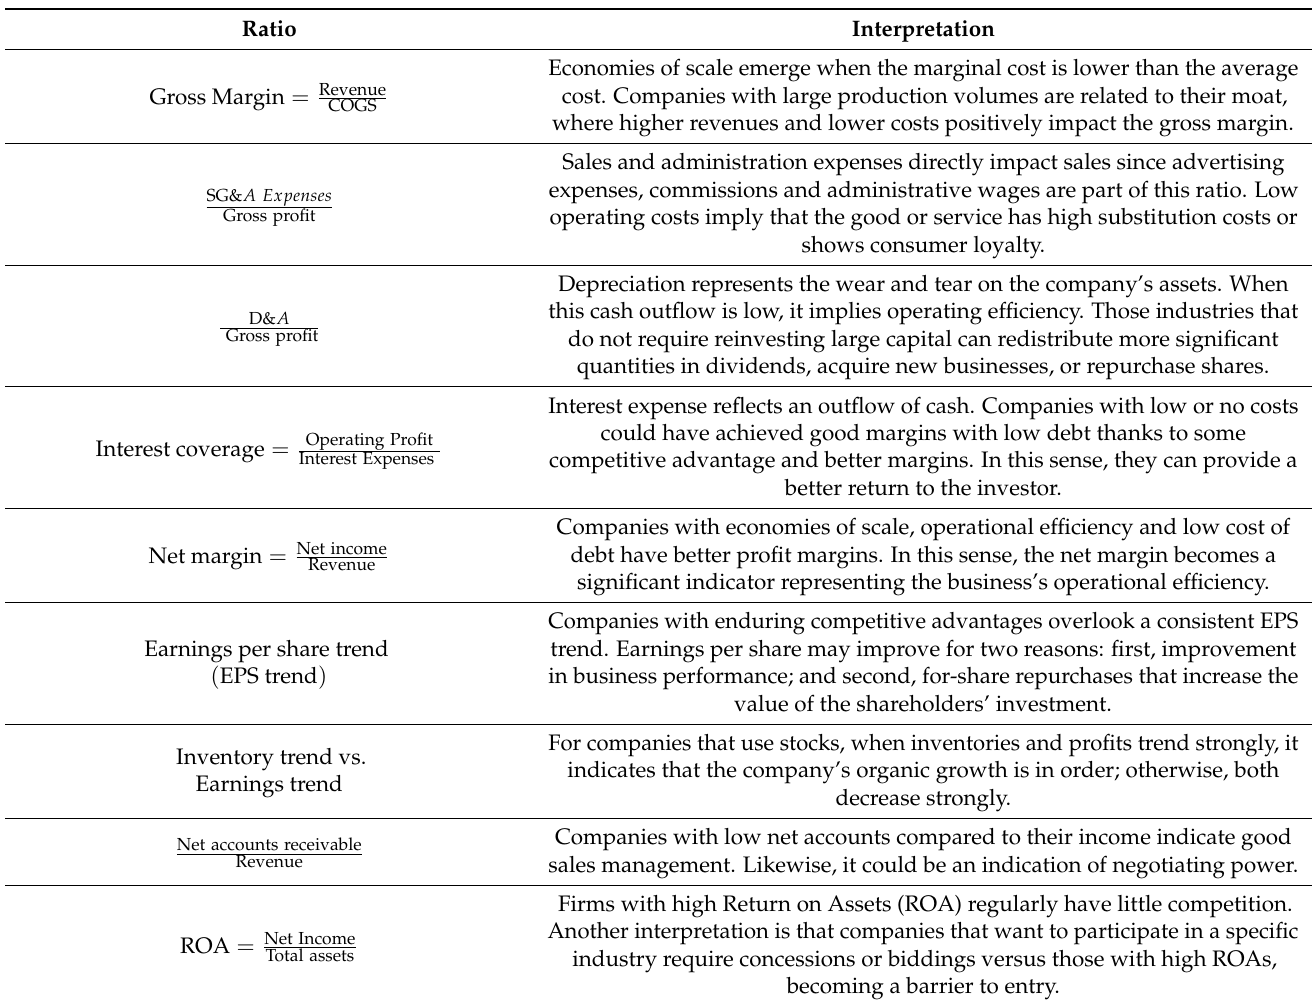
Table 2. Ratios to select competitive advantages